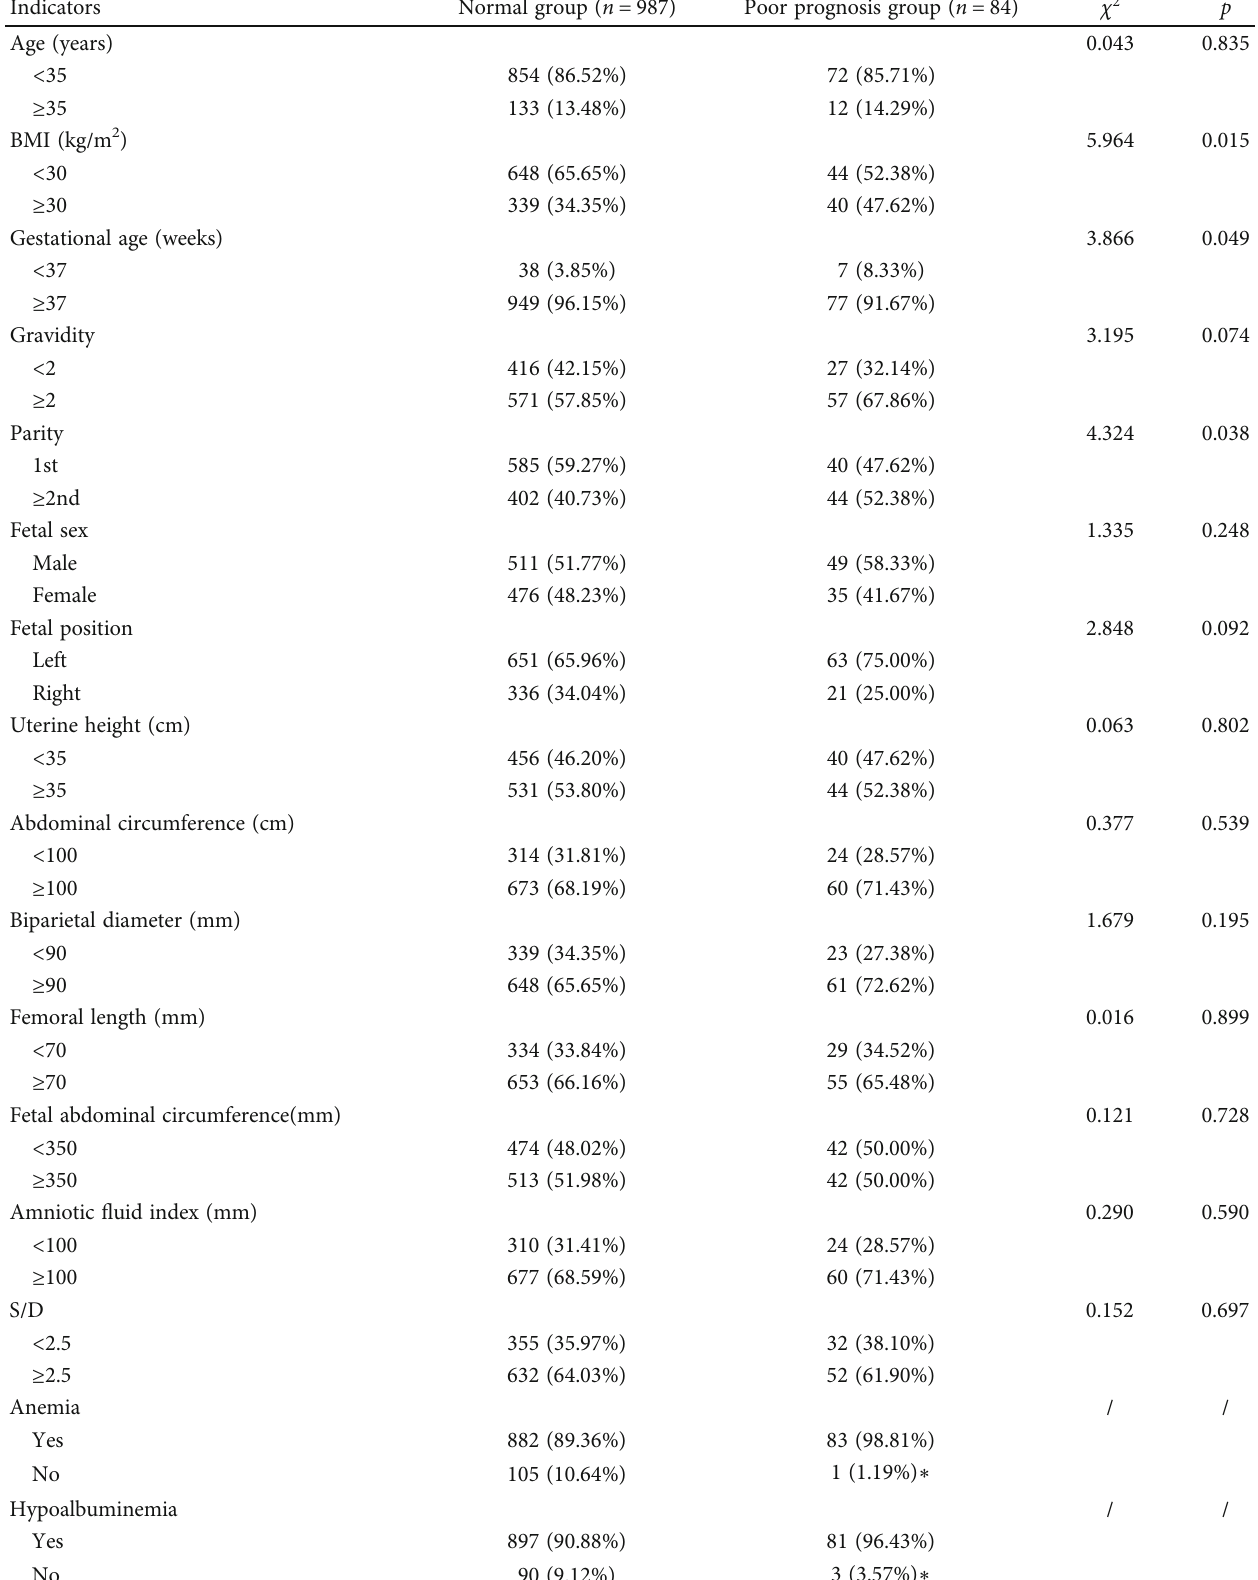
Table 4: Univariate logistic regression analysis of risk factors for poor prognosis of